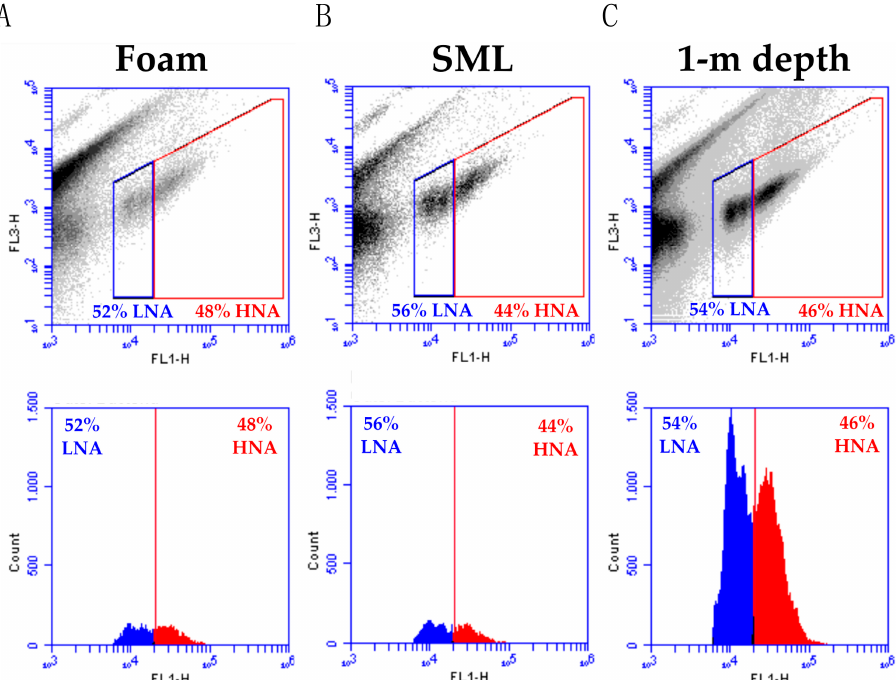
Figure 4. Representative example of high nucleic acid (HNA) and low nucleic acid (LNA) cells in ( A ) foam, ( B ) sea-surface microlayer (SML), ( C ) 1-m depth samples from 21st April 2016 (Set 2). Here, more than half of all bacterial cells belong to LNA cells and potentially include Cand. Patescibacteria having small genomes.